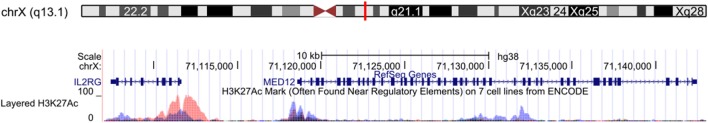
Xq13.1 duplication region shared by affected siblings. The red box shows exons 25–28 of the MED12 gene, which were duplicated in the two affected patients with idiopathic T-cell lymphopenia. This region contains H3K2AC histone marks from the Encyclopedia of DNA Elements. UCSC Genome Browser GRCh38/hg38 assembly (16).